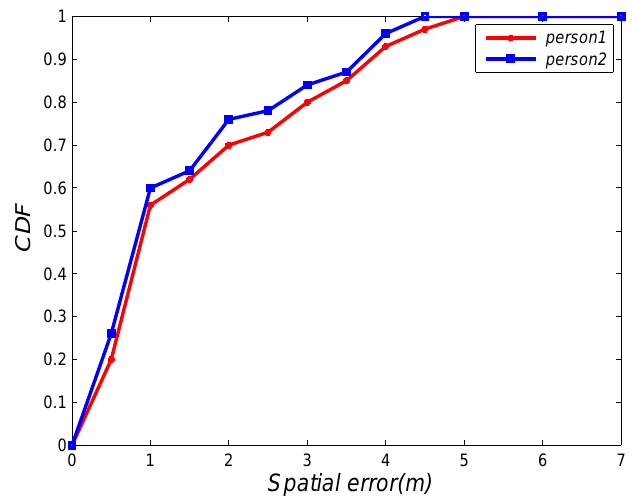
Figure 11. Localization result with base station distance is 50